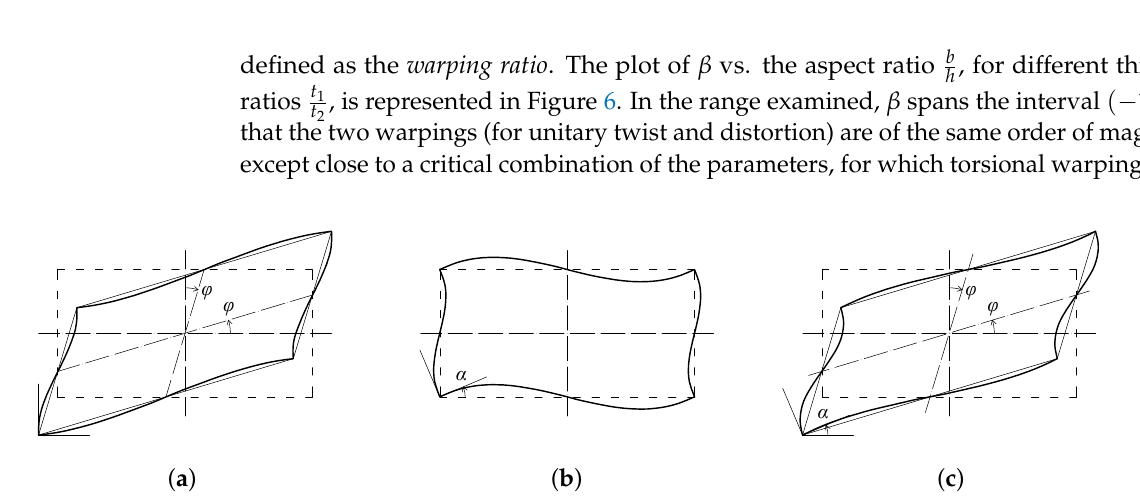
Figure 4. Distortional deflection: ( a ) translating joints, ( b ) rotating joints, and ( c ) superposition of displacements.